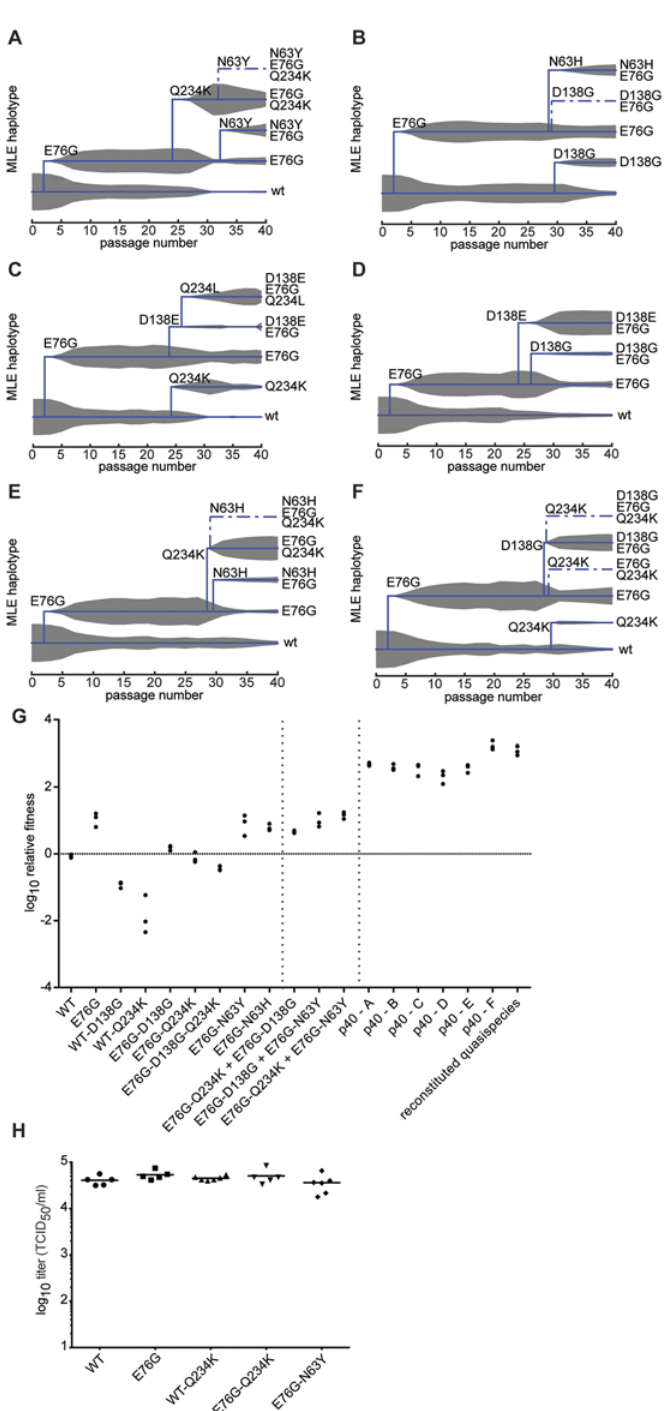
Fig 5. Maximum likelihood estimates of haplotypes present within the passaged virus populations and contribution of minority variants to population fitness. MLE was performed using the frequency values of each mutation at each passage in the deep sequence data for replicates a-f (A-F). The trees indicate the presence of wildtype genotype (lowest line on tree) along with the predicted haplotypes as they emerge during the passage series (x-axis). Solid lines indicate haplotypes with highest MLE scores, dashed lines indicate alternative haplotypes that could exist, with lower scores. The thickness of grey area indicates the expected frequency of each haplotype in the population, according to deep sequence data. (G)